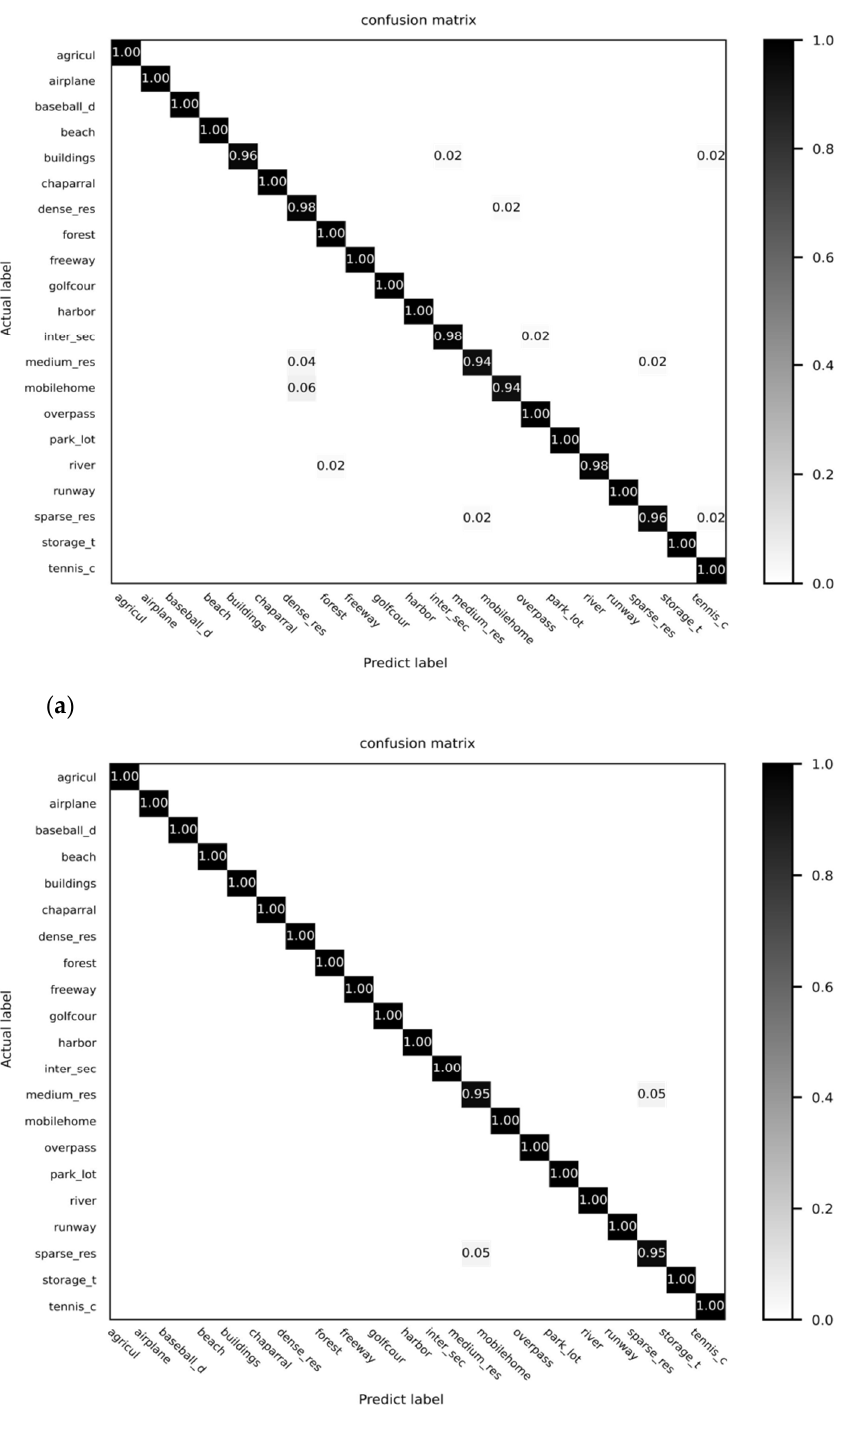
Figure 6. Confusion matrices of the UC-Merced dataset. ( a ) Linear evaluation under the 50% training ratio. ( b ) Linear evaluation under the 80% training ratio.